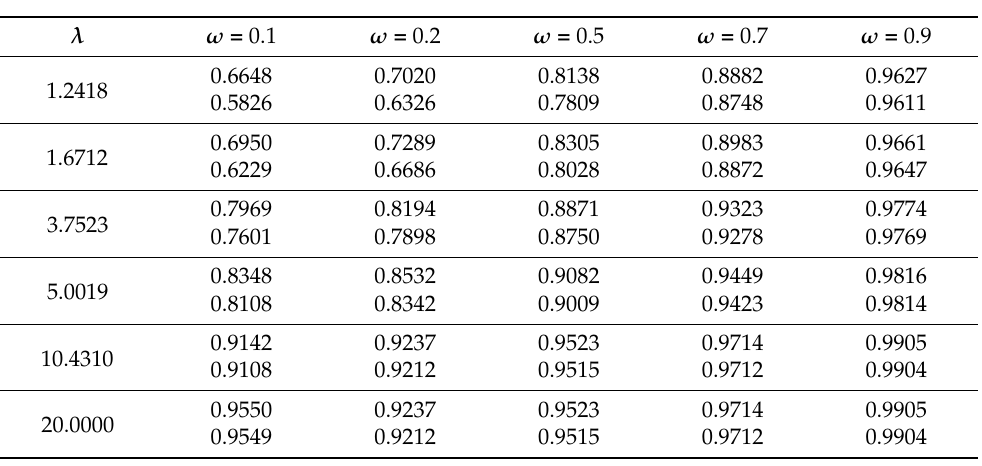
R ω ( T J . S ( (cid:107) Y (cid:107) 2 ) , µ ) R ω ( T J . S + ( (cid:107) Y (cid:107) 2 ) , µ ) and for d = 4 and ω = 0.1, 0.2, R ω ( T 0 , µ ) R ω ( T 0 , µ )